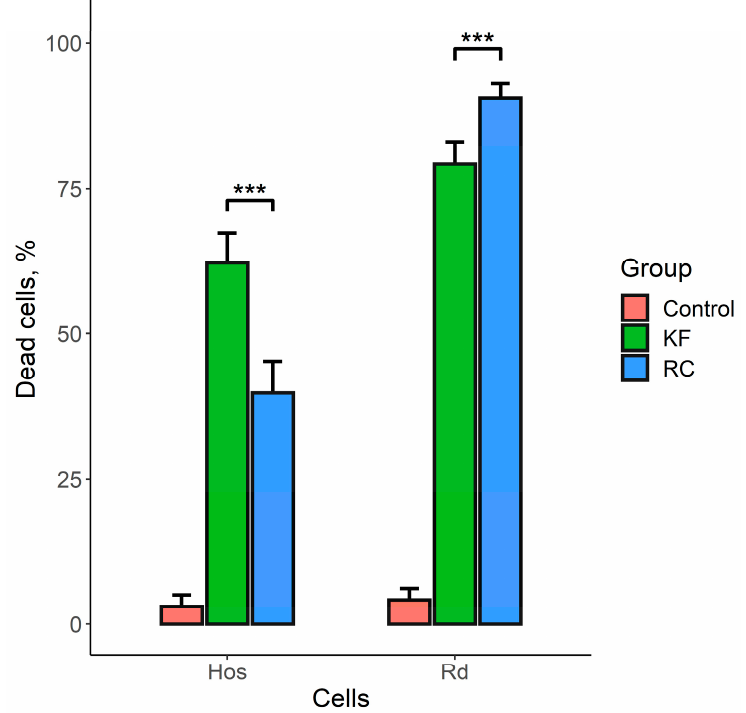
Figure 4. Percent cell death of HOS and Rd lines after 72-h incubation with kudzu flower (KF) and clover (RC) extracts ( p < 0.001). The representative figure shows that KF and RC extracts significantly inhibited the proliferation of HOS and Rd cells compared to the control cell lines. *** corresponds to p < 0.001.